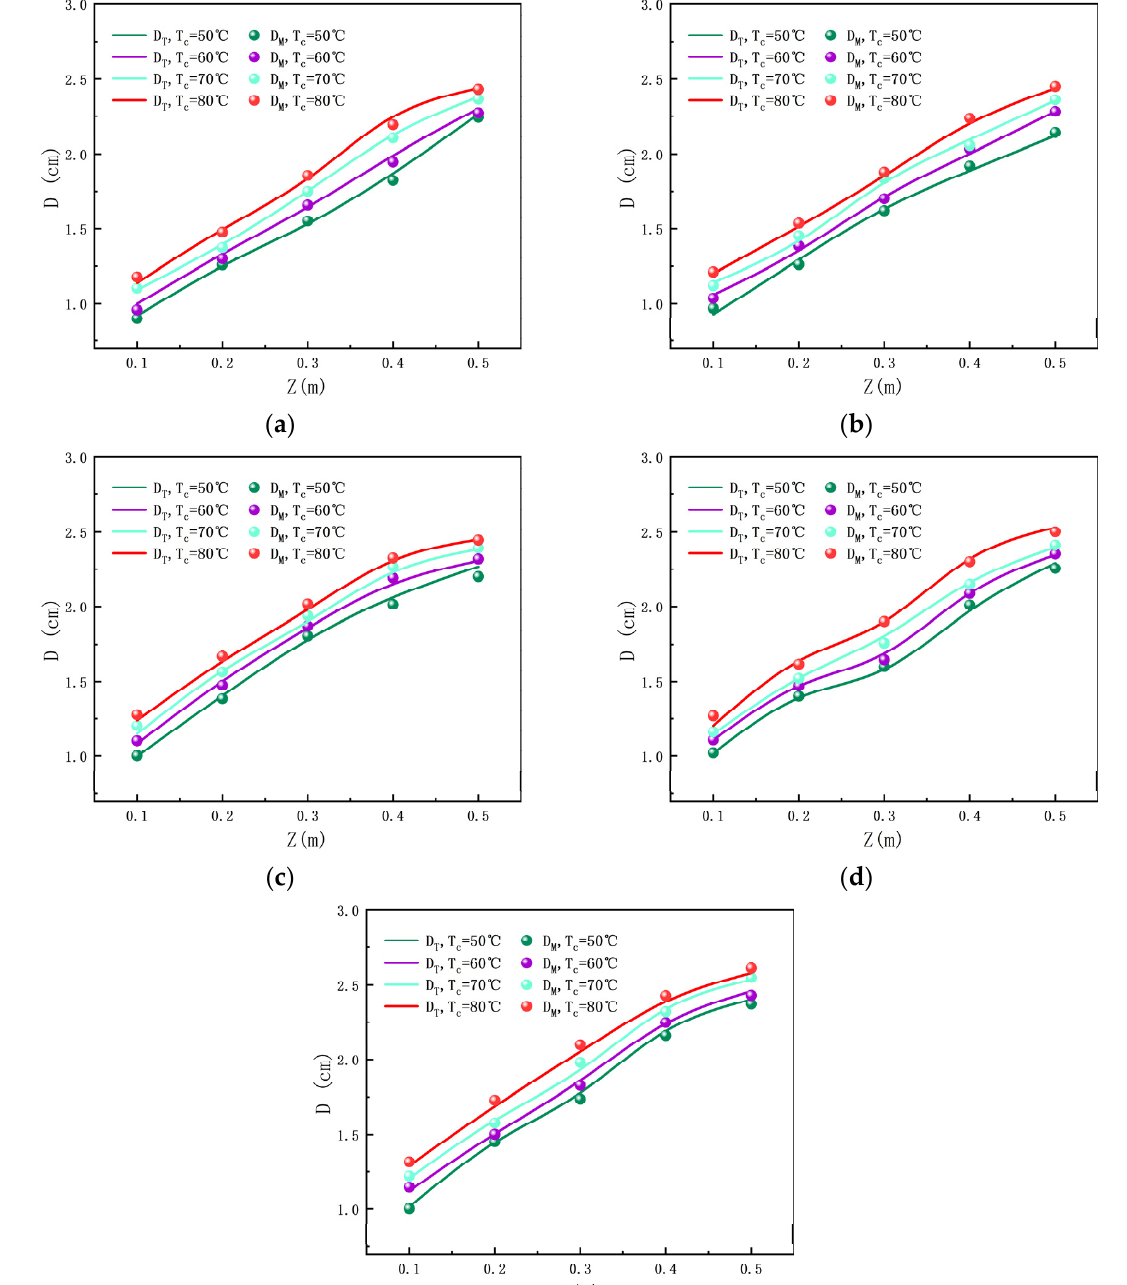
Figure 4. The relationship between bubble diameter and height (Z) under different flow rate ratios. ( a ): m d /m c = 1:5. ( b ): m d /m c = 1:4. ( c ): m d /m c = 1:3. ( d ): m d /m c = 1:2. ( e ): m d /m c = 1:1.